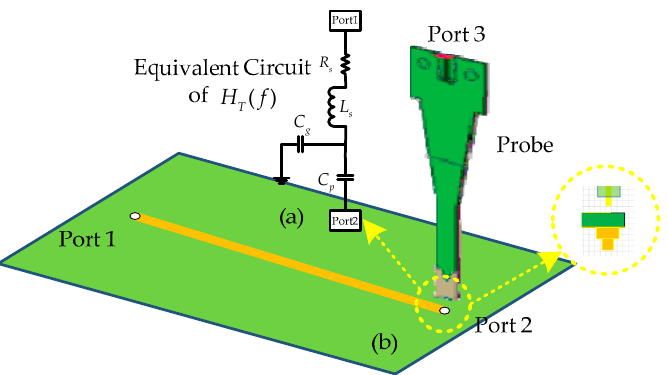
Figure 2. Full-wave model of the probe and printed trace.